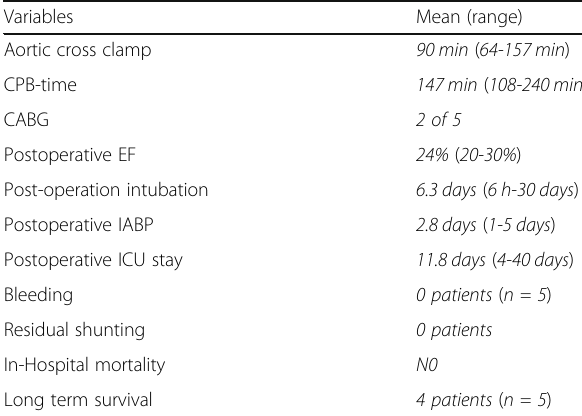
Table 2 Operative and postoperative